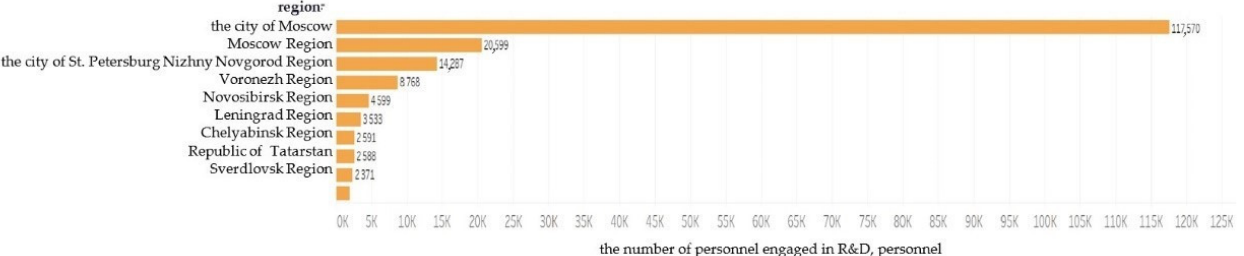
Figure 5. Size of incoming slacks by the indicator of the number of personnel engaged in R&D (res_hum).